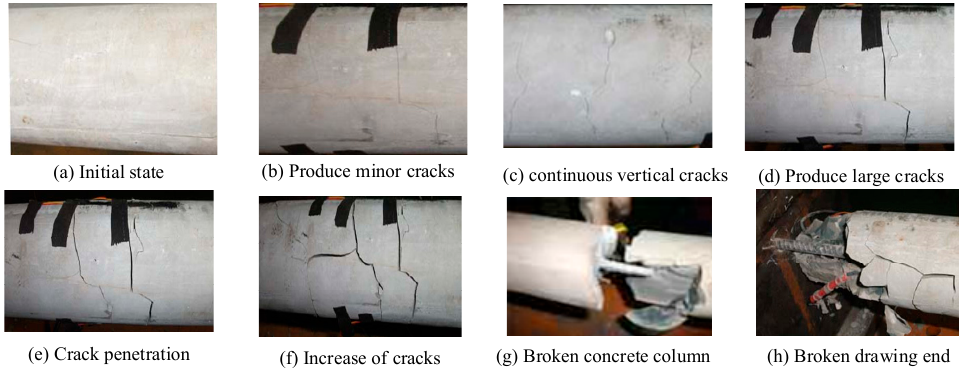
Figure 6. Failure process of reinforced concrete anchorage in pull-out test.